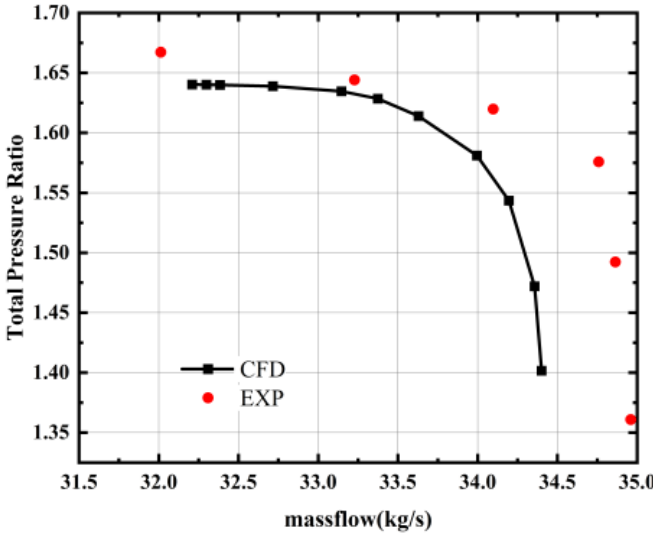
Figure 4. Comparison of simulation and experimental results of NASA Stage 67.